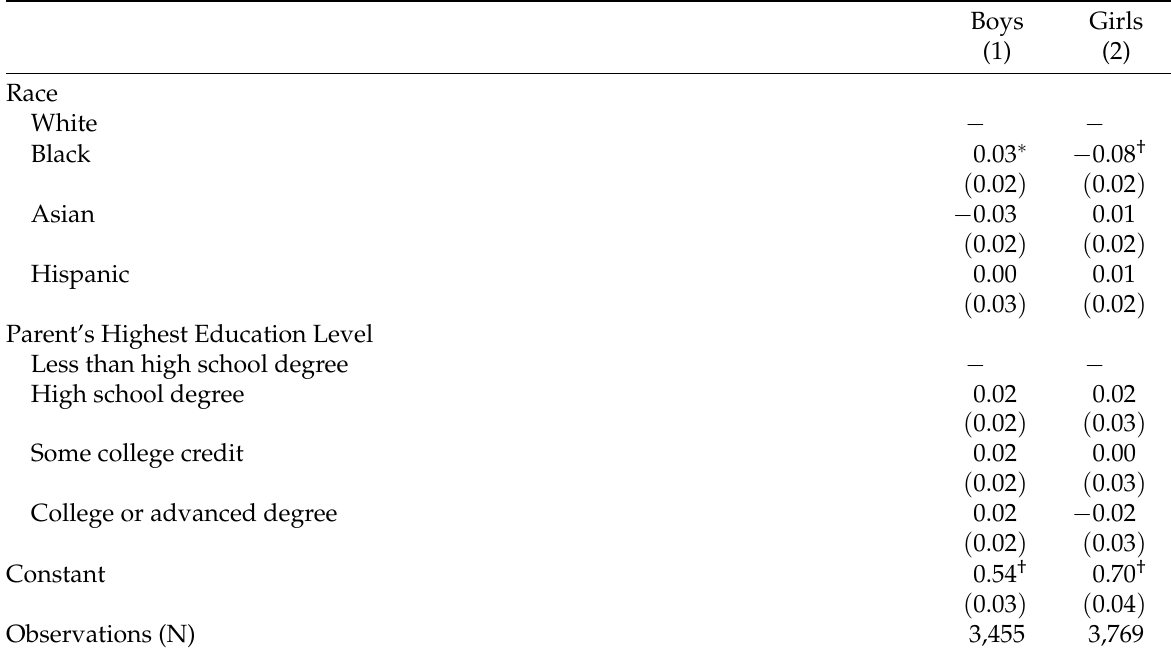
Table 3: Regression results that show relationship between respondent characteristics and gender typicality among boys and girls.